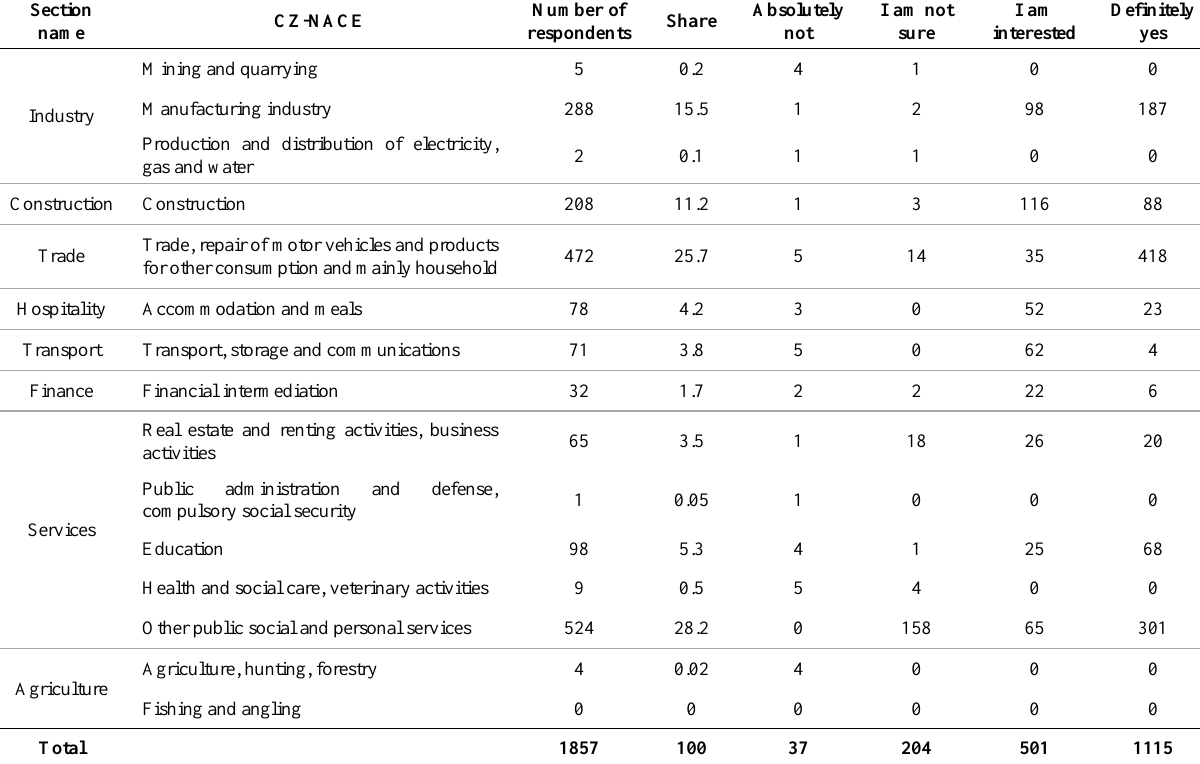
Figure 2. Expression of the overall interest of the respondents from the Olomouc agglomeration in the services of the Neuromarketing Center. Figure 2 expresses the results of respondents' interest in the services of the Neuromarketing Center. Table 3 Expression of the overall interest of the addressed respondents from the Olomouc agglomeration in the services of the Neuromarketing Center according to individual CZ-NACE and the degree of